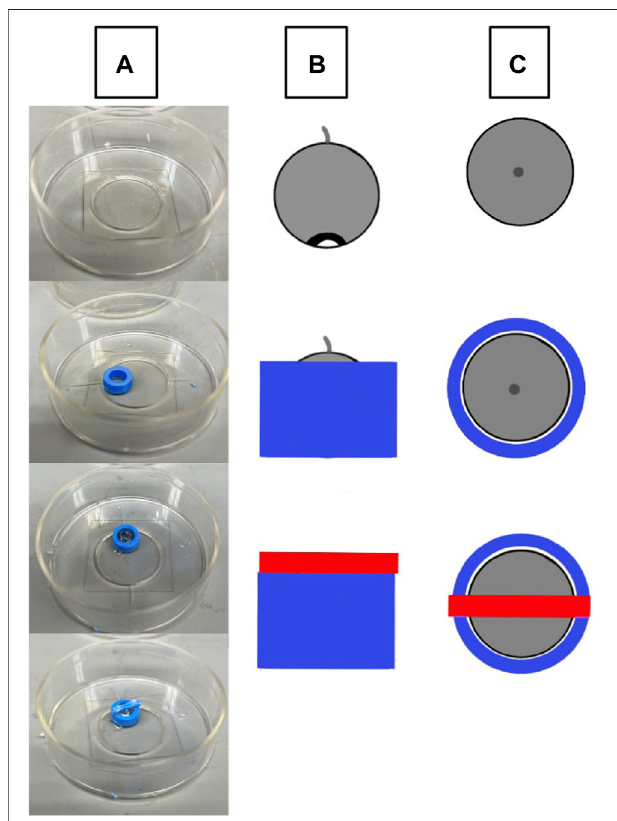
FIGURE 1 | Schematic of eye stabilization using a 3D printed holder. (A) A 3D printed holder (blue) is adhered to a MatTek p35 cover slip, the intact globeisplacedwithintheholderwiththecorneafacing down,and thecoveris placed over the center of the eye and adhered to the holder. (B) A lateral view of eye orientation (grey circular object) and the relative sizes of the holder (blue) and weighted cover (red). (C) The top-down view of the holder setup.